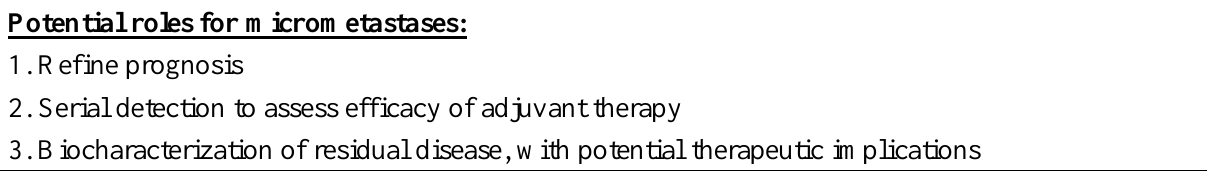
Table 2. Detection of micrometastases: potential roles in early breast cancer. Potential roles for